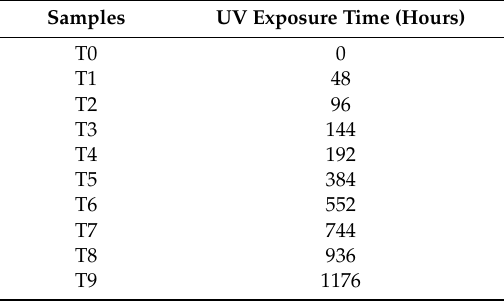
Table 1. UV exposure times of samples of styrene-ethylene-butadiene-styrene